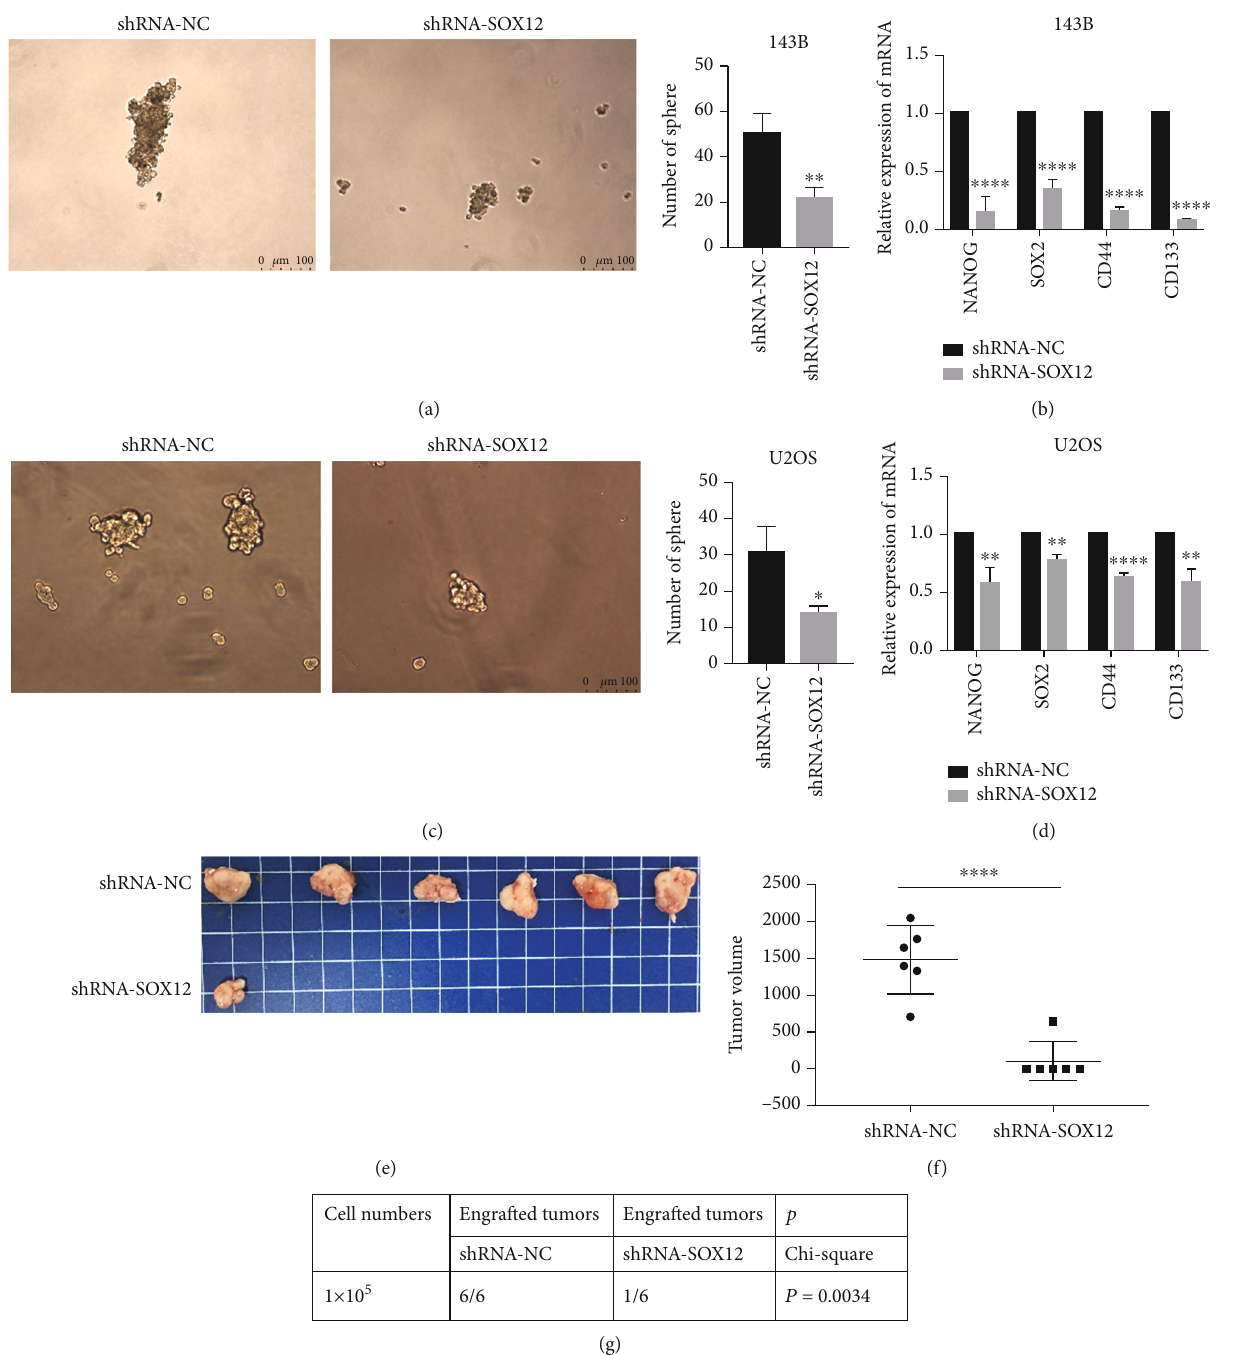
Figure 4: SOX12 downregulation inhibits the stem cell-like properties of osteosarcoma cells. (a) SOX12 knockdown inhibits the spheroidizing ability of 143B cells. (b) SOX12 knockdown reduces stemness marker expression in 143B cells. (c) SOX12 knockdown inhibits spheroidizing abilities in U2OS cells. (d) SOX12 knockdown reduces stemness marker expression in U2OS cells. (e – g) SOX12 knockdown inhibits tumor size and numbers in nude mice. ∗ p < 0 : 01 , ∗∗ p < 0 : 001 , ∗∗∗∗ p < 0 : 0001